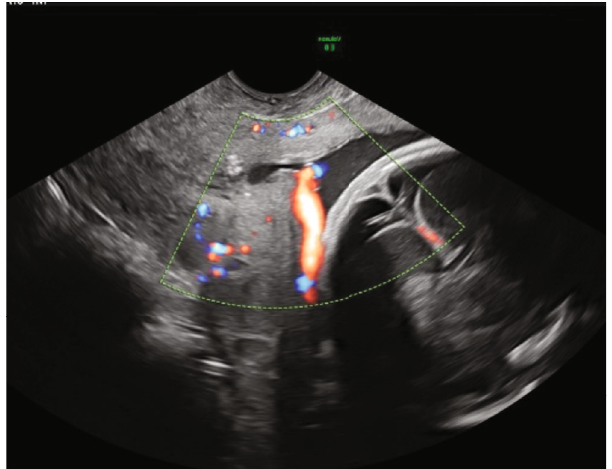
Figure 1: Transvaginal ultrasound image at 16 weeks showing vasa previa.